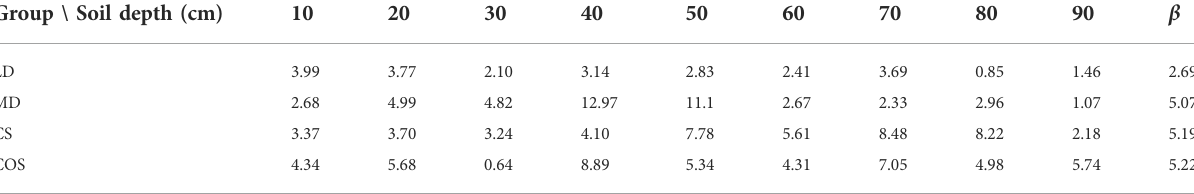
TABLE 7 Deviation of soil water content under different drought